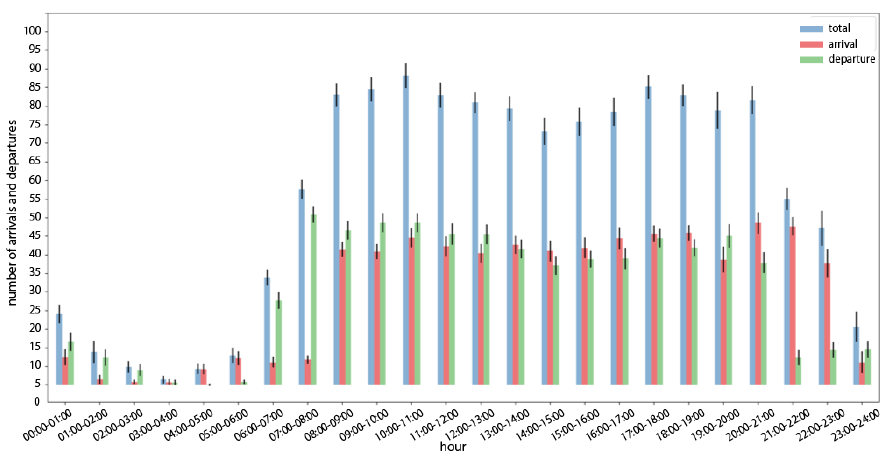
Figure 2. Mean hourly numbers of flight departures and arrivals for each hour of the day, with standard deviations.